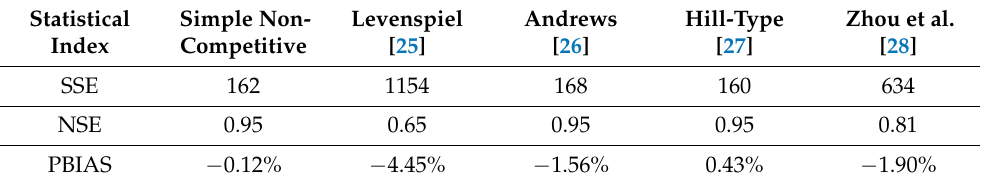
Table 1. The statistic indices for the FNA inhibition models examined.